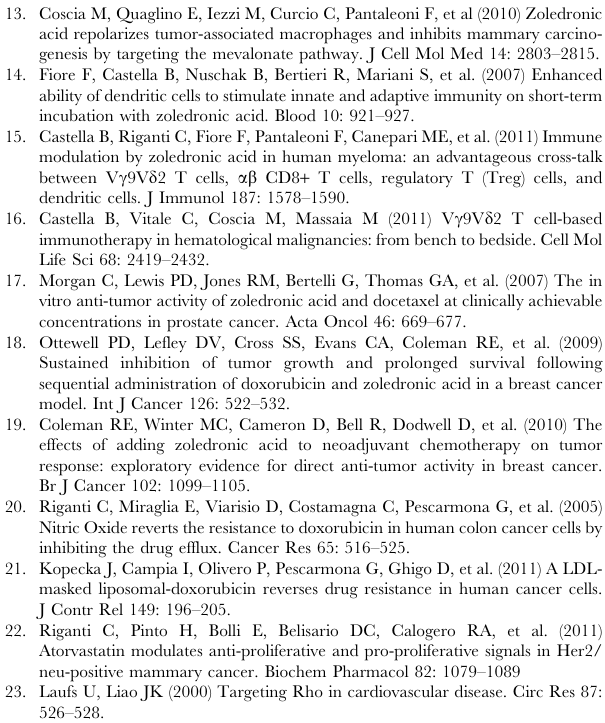
Figure S1 Effects of different combinations of ZA and doxorubicin on the intracellular doxorubicin accumula- tion. HT29, HT29-dx and HMM cells were treated with 1 m mol/ L Dox alone or Dox in combination with 1 m mol/L ZA under different conditions: 1) Dox and ZA were co-incubated for 48 h (ZA & Dox); 2) Dox was added first for 24 h, ZA was added for a further 48 h (Dox + ZA); 3) ZA was added first for 48 h, Dox was added for a further 24 h (ZA + Doz). Intracellular Dox concentra- tions were significantly higher in HT29 than in HT29-dx and HMM cells (*p , 0.001). In MDR + cells, intracellular Dox concentrations were significantly higher than untreated cells only when ZA preceded Dox (HT29-dx: u p , 0.05; HMM: e p , 0.02). Bars represent the mean 6 SD of 3 independent experiments. Figure S2 Biotinylation assays to detect surface calre- ticulin. HT29, HT29-dx, and HMM cells after incubation with ZA and/or Dox. Tumor cells were incubated for 48 h without (CTRL) or with 1 m mol/L ZA, for 24 h with 1 m mol/L Dox, for 48 h with 1 m mol/L ZA, followed by 1 m mol/L Dox for a further 24 h (ZA + Dox). Surface CRT was measured in biotinylated extracts; total CRT was measured in the whole cell lysates from the same cells by Western blotting. The results are representative data from one of 2 experiments.